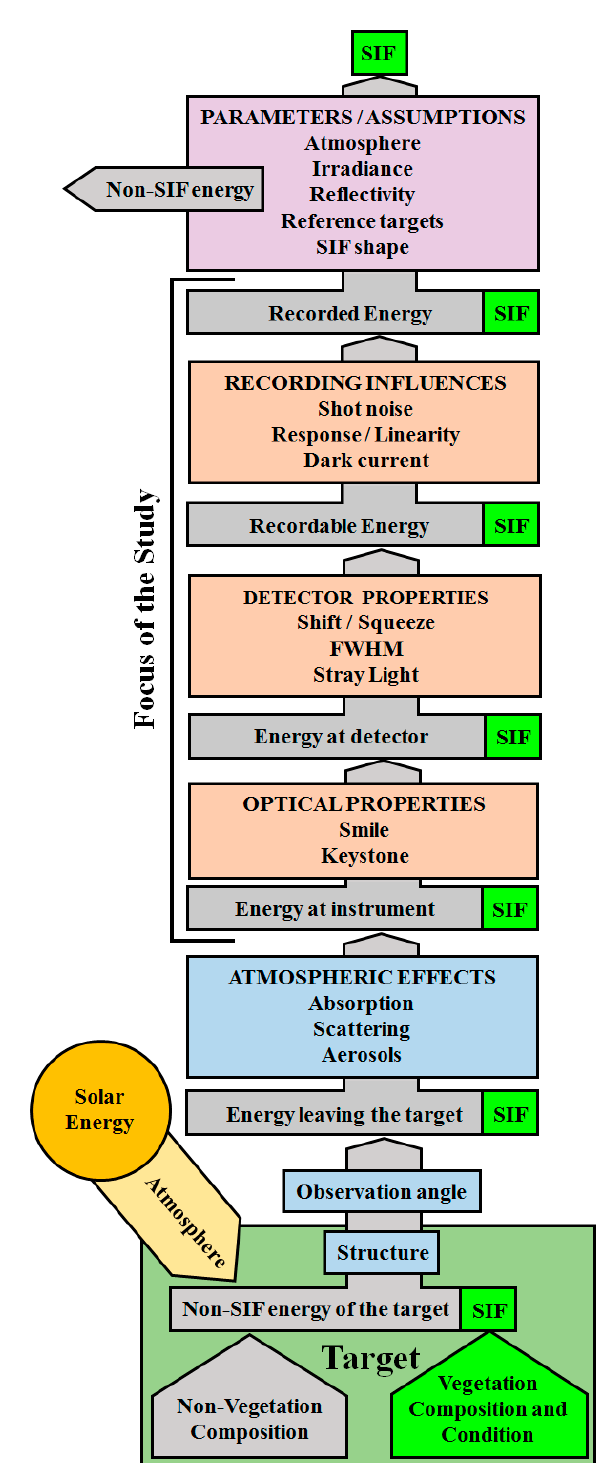
Figure 2. Flow-chart of potential influences on SIF signal. Influences in orange boxes are actively investigated in this study. Green components represent the SIF portion of the signal, and gray components represent the non-SIF portion of the signal.